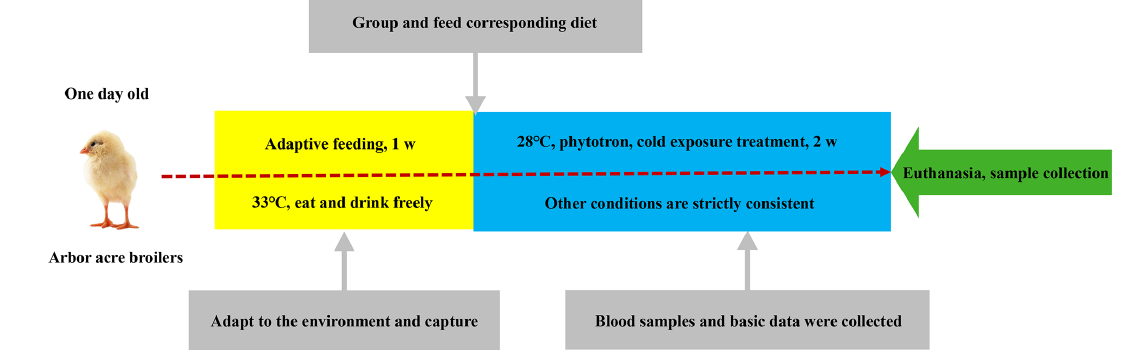
Figure 1. Timeline of the treatment